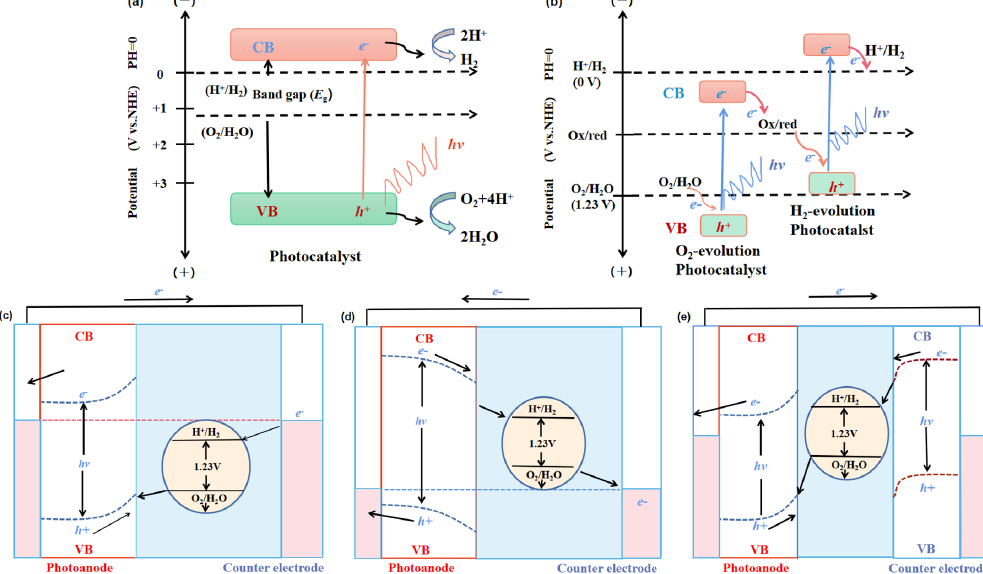
Figure 2. Energy schematic diagram based on ( a ) one-step water splitting and ( b ) Z-scheme mechanism; and photoelectrochemical water splitting using ( c ) a photoanode, ( d ) photocathode, and ( e ) photoanode and count electrode in tandem systems for photocatalytic water splitting, respectively